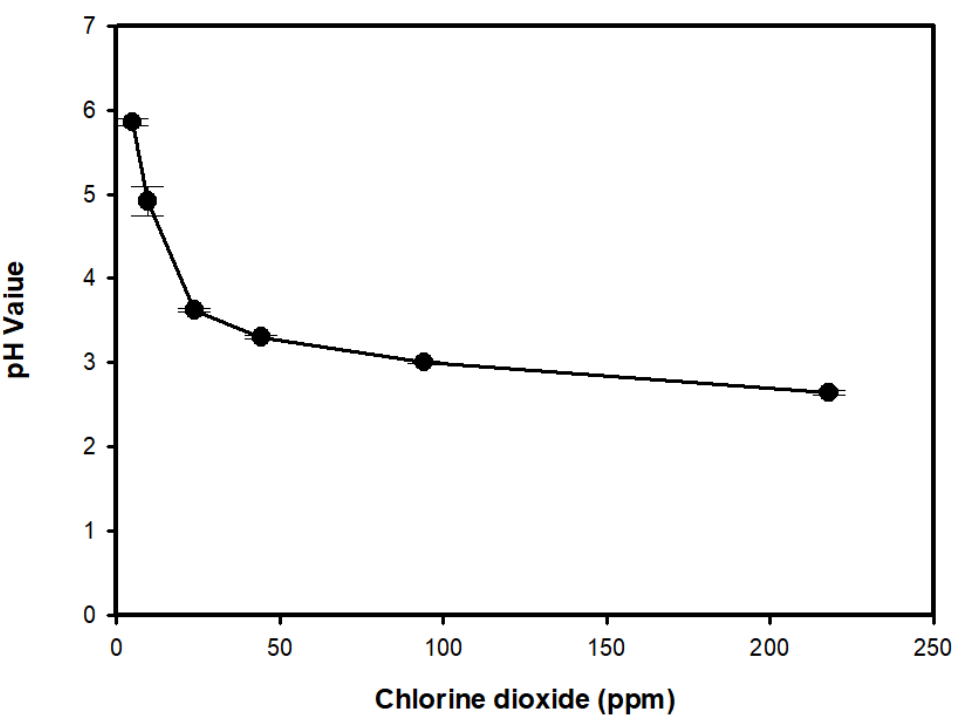
Figure 2. The relationship between the ClO 2 concentration of ACD and pH in water.